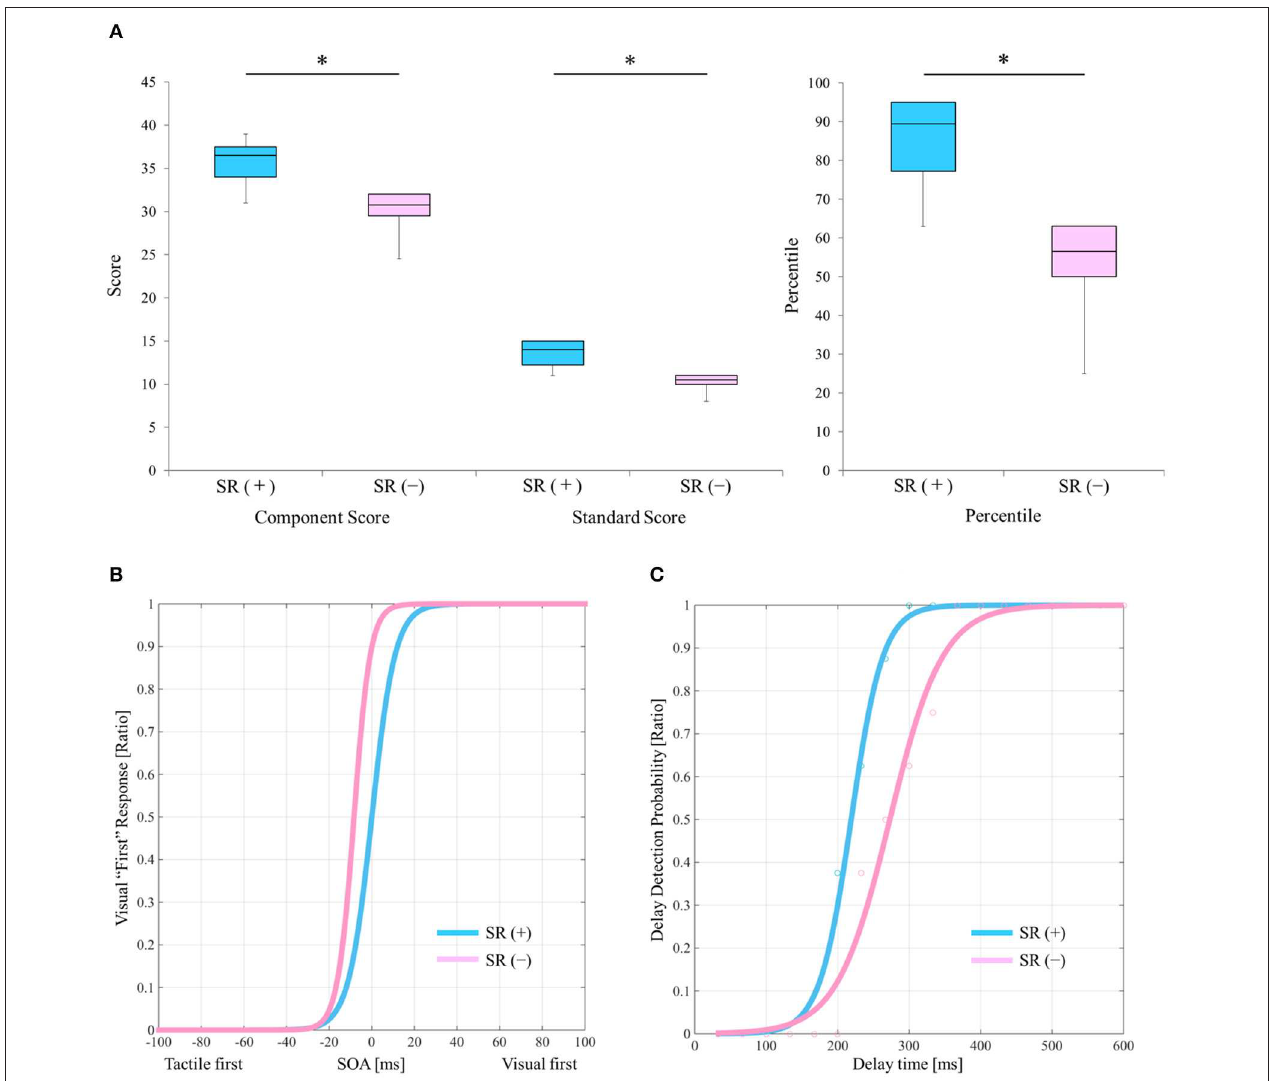
FIGURE 2 | Results of the manual dexterity test and experimental tasks under the SR on-and SR off-conditions. (A) Comparison results of manual dexterity test scores between the SR on- and SR off-conditions. SR ( + ), stochastic resonance on-condition; SR (–), stochastic resonance off-condition; Blue box, SR on-condition; Pink box, SR off-condition. * P < 0.05. Lines represent the range of the minimum and maximum. Boxes represent the lower, median, and upper quartiles. (B) The “visual first” response probability curves of the SR on- and the SR off-conditions in the TOJ tasks. Blue curve, SR on-condition; Pink curve, SR off-condition. (C) Delay detection probability curves of the delayed visual feedback detection tasks in the SR on- and off-conditions. Blue curve, SR on-condition; Pink curve, SR off-condition.